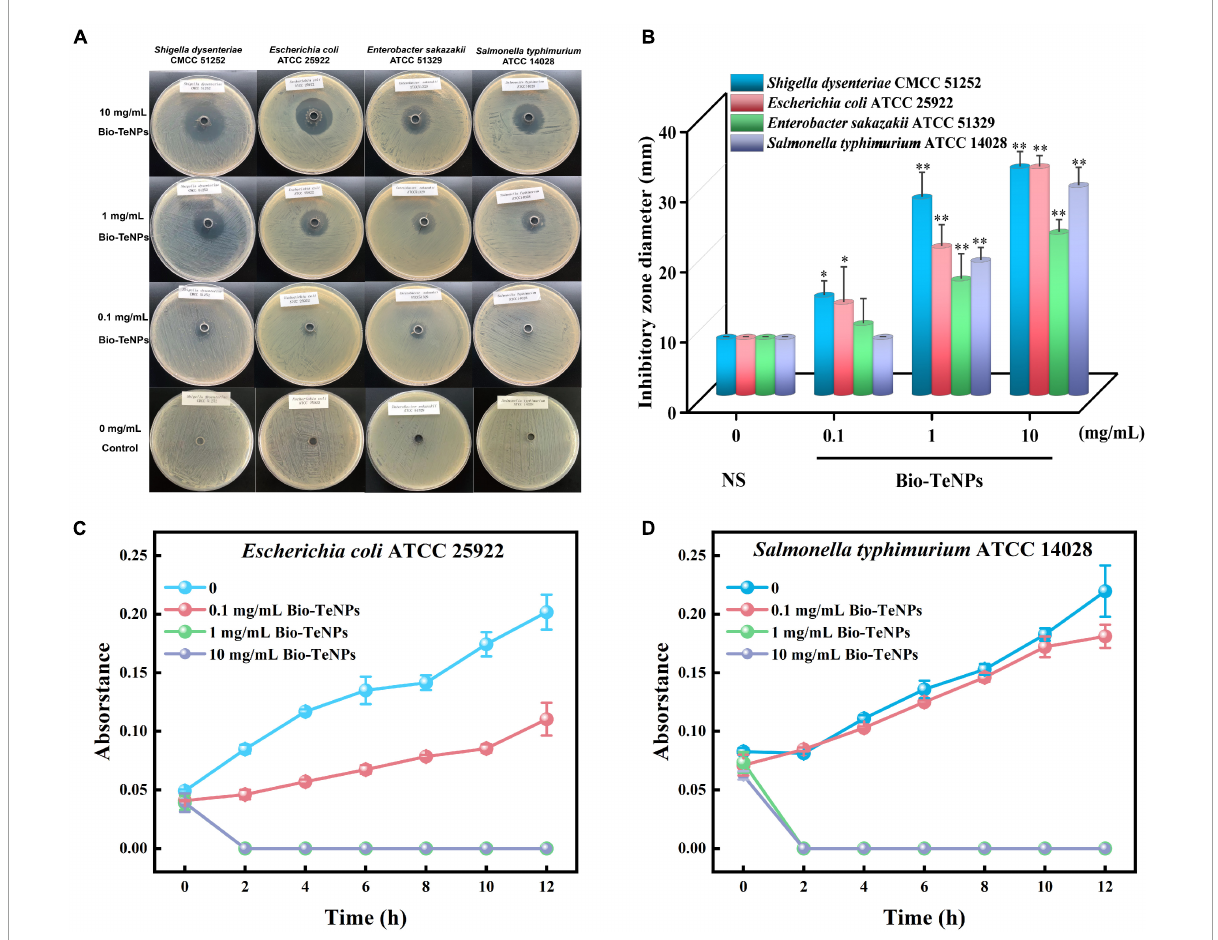
FIGURE6 Antibacterial activity of Bio-TeNPs. (A) The inhibition zone images of 0.85% (w/v) normal saline (NS) and Bio-TeNPs (10, 1, and 0.1 mg/mL) on S . dysenteriae , E . sakazakii , E . coli, and S . typhimurium . (B) The inhibition zone diameter of NS and Bio-TeNPs (10, 1, and 0.1 mg/mL) on S . dysenteriae , E . sakazakii , E . coli, and S . typhimurium . (C) The growth curve of E . coli in MHB medium with or without 1 mg/mL Bio-TeNPs. (D) The growth curve of S . typhimurium in MHB medium with or without 1 mg/mL Bio-TeNPs. Data are shown as the mean ± SD ( n =